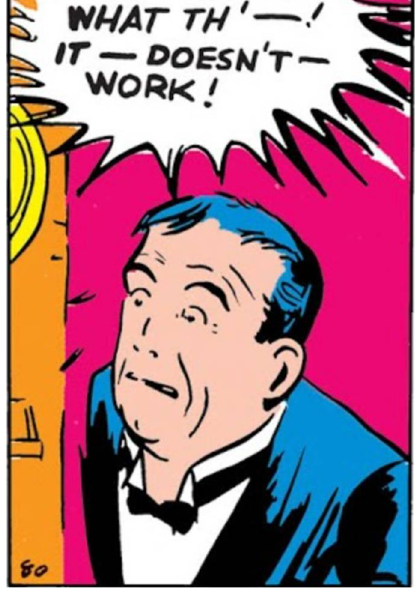
Figure 13. Joe Shuster, Close-Up of Superman Knocking on a Door (panel No. 20), 1938. Siegel and Shuster (July 1938), “Superman”, Action Comics #2 (Siegel and Shuster 1938b, p. 24). © DC Comics.